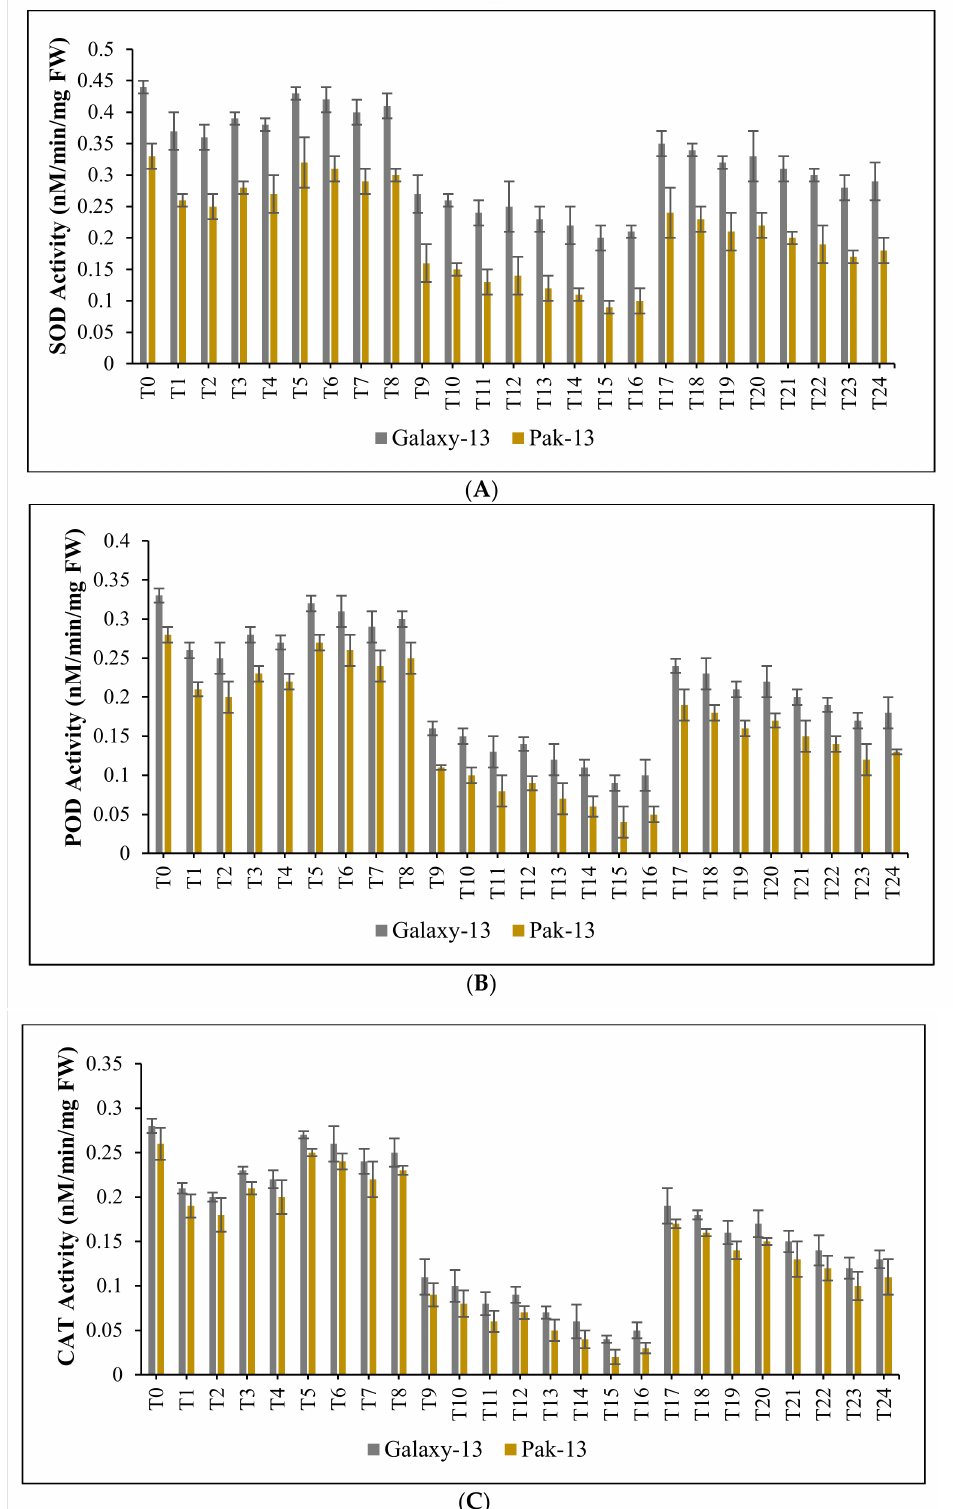
Figure 6. ( A ): effect of phytogenically synthesized bimetallic Ag/ZnO nanomaterials and nitrogen- based fertilizers on SOD activity of wheat varieties; ( B ): effect of phytogenically synthesized bimetallic Ag/ZnO nanomaterials and nitrogen-based fertilizers on POD activity of wheat varieties; ( C ): effect of phytogenically synthesized bimetallic Ag/ZnO nanomaterials and nitrogen-based fertilizers on CAT activity of wheat